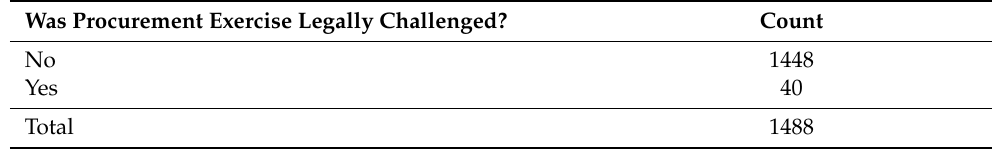
Table 5. Summary of number of legal